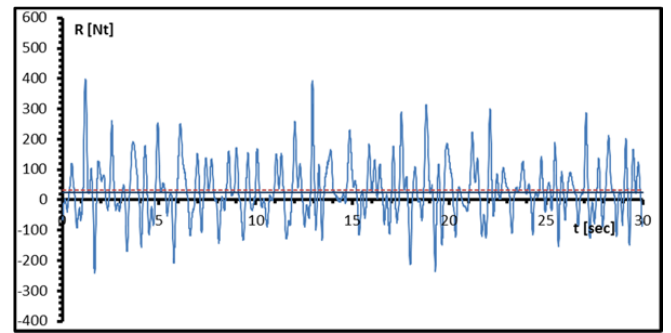
Figure 19. Resistance time series for Experiment #7.